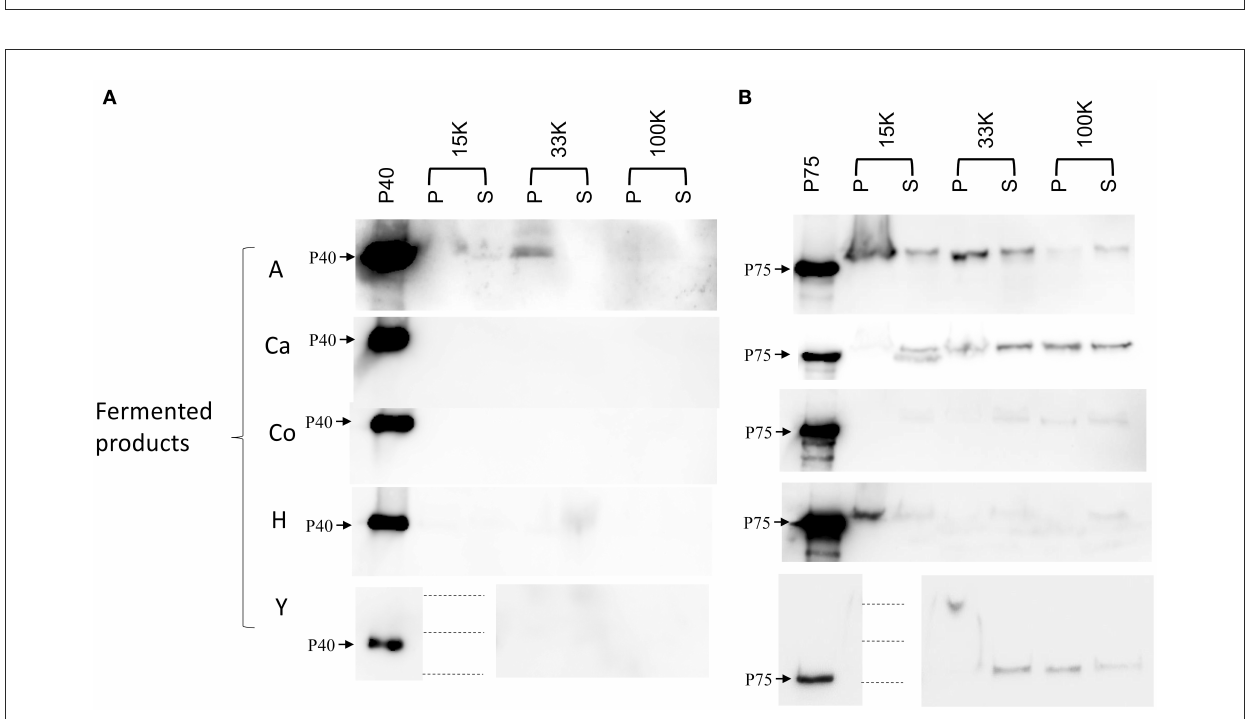
FIGURE2 Detection of P40 and P75 in the pellets (P) and supernatants (S) of the sequential centrifugation (15, 33, and 100K) of five fermented dairy products (A, Ca, Co, H, and Y). (A) Shows all samples detected with anti-P40 rabbit antibodies, and (B) shows samples detected with anti-P75 rabbit antibodies. Purified His-tag P40 and P75 were used as references for the corresponding blots. It was technically impossible to load on the PAGE samples of 15K pellet of product Y; hence, both P and S samples of product Y were omitted, and the image has been split to align with the track annotations above.